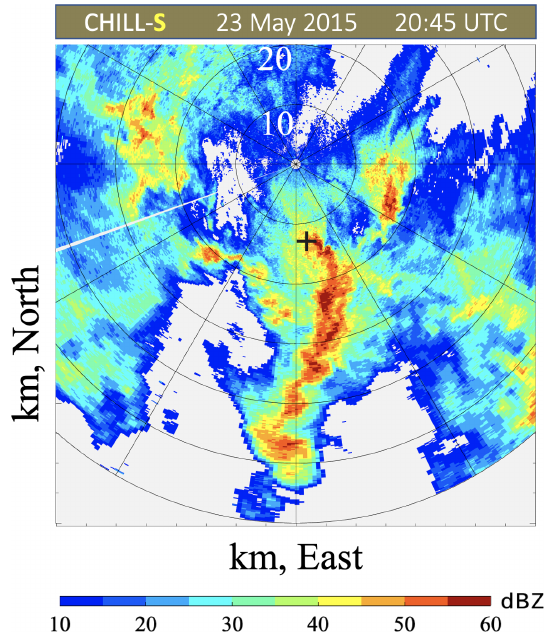
Figure 2. Low elevation angle (1 . 5 ◦ ) PPI sweep of S-band reflec- tivity ( Z H ) at 20:45UTC. The “+” marks the location of the instru- mented site (MPS and 2DVD).